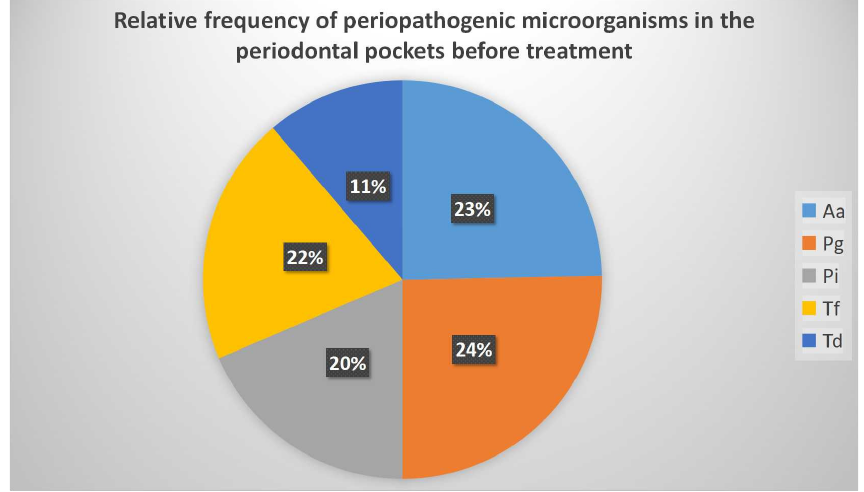
Figure 3. The presence of bacteria in the initial samples (A1 and B1). The colors represent different microbial complexes. (Aa) Aggregatibacter actinomycetemcomitans, (Pg) Porphyromonas gingivalis , (Pi) Prevotella intermedia , (Tf) Tannerella forsythia , (Td) Treponema denticola .